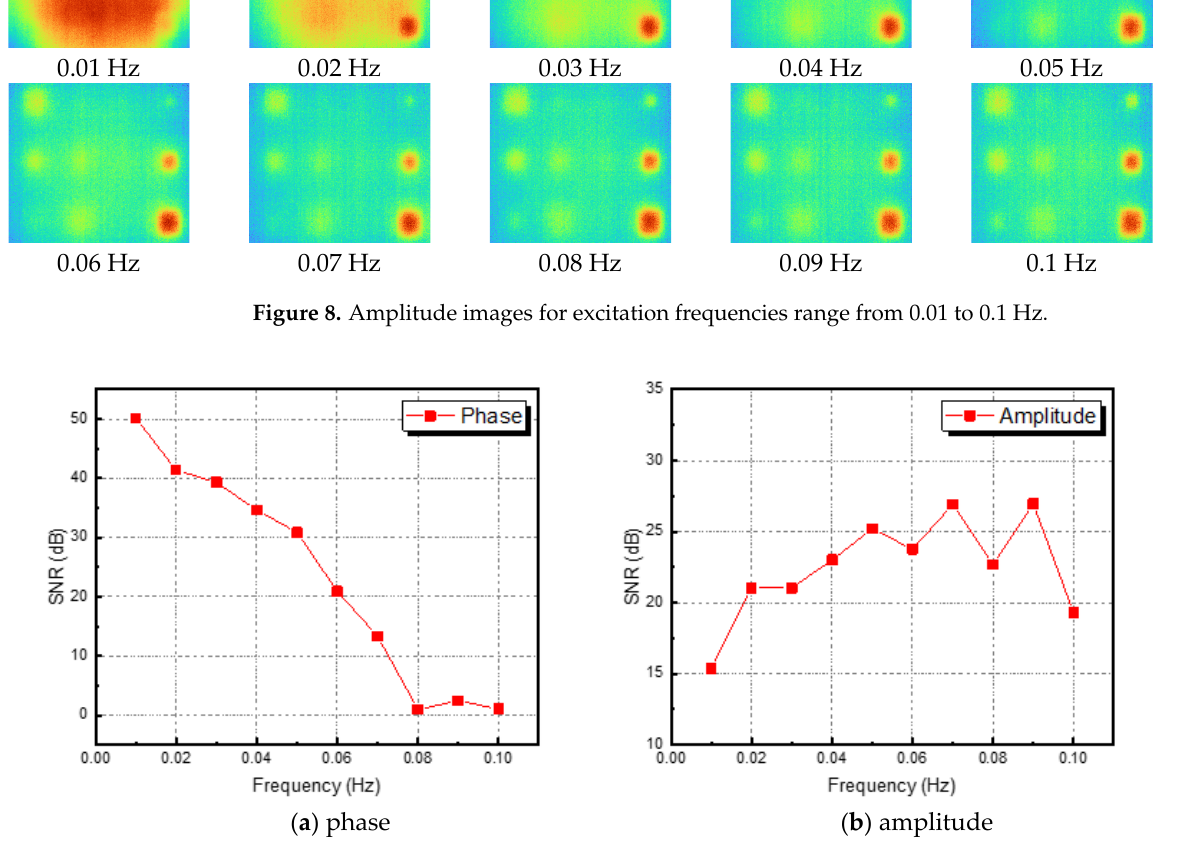
Figure 9. SNR values of phase and amplitude for excitation frequencies range from 0.01 to 0.1 Hz for optimal excitation frequency analysis.